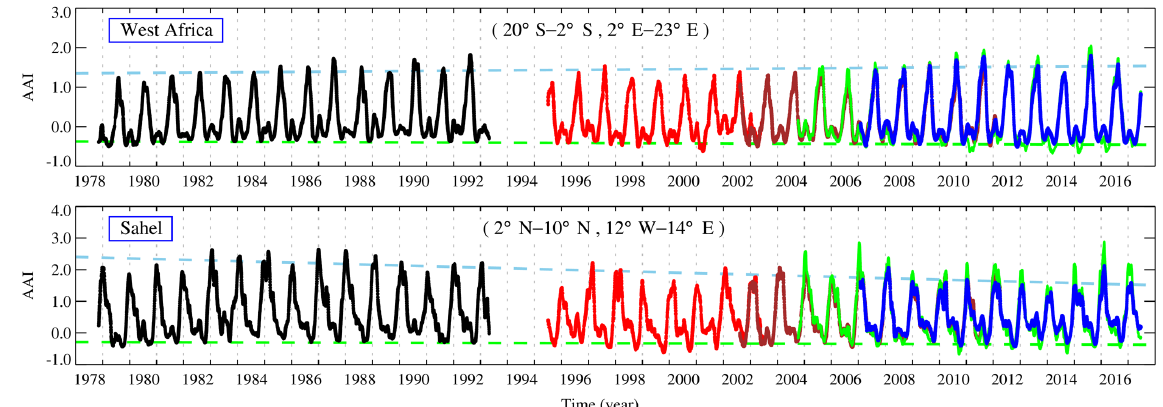
Figure 4. Time series of regional mean absorbing aerosol index (AAI) for two aerosol regions. The time series consists of data from TOMS (black), GOME (red), SCIAMACHY (brown), OMI (light green), and GOME-2 (blue). The latitude and longitude ranges that define the regions are provided in the plot windows. The dashed green lines indicate linear fits to the yearly minima of the time series, and illustrate the stability of the data records. The dashed blue lines represent linear fits to the yearly maxima of the time series. These describe trends in aerosol presence for the regions over the entire time range covered by the time